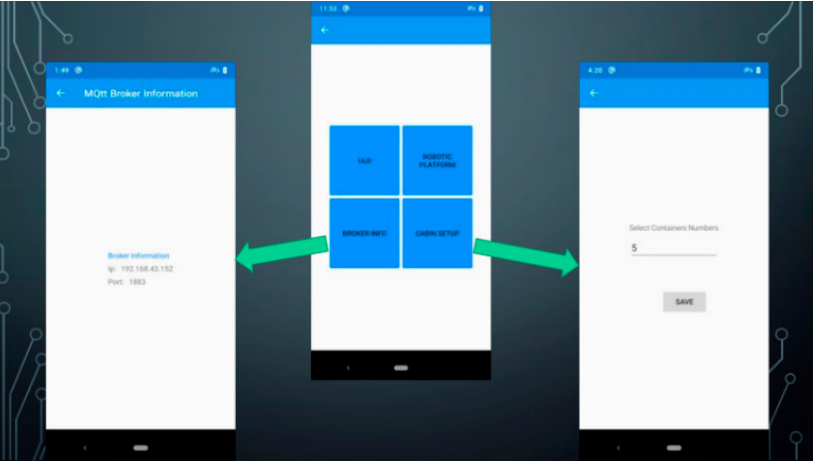
Figure 9. Main menu.